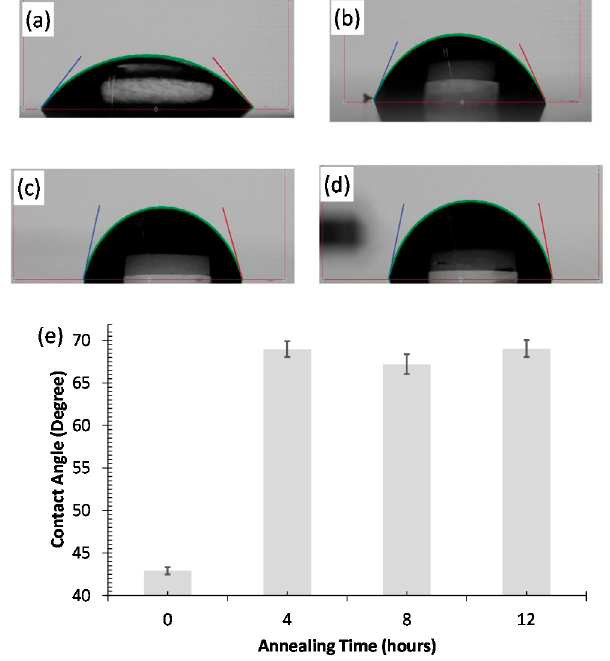
Figure 2. Images of water droplets on four COC wafers coated with GO ( a ) without baking, and ( b – d ) baked at a temperature of 100 °C for 4 h, 8 h, and 12 h, respectively. ( e ) The variation in the water contact angle on GO-coated COC wafers vs. the annealing time (four readings for each sample).